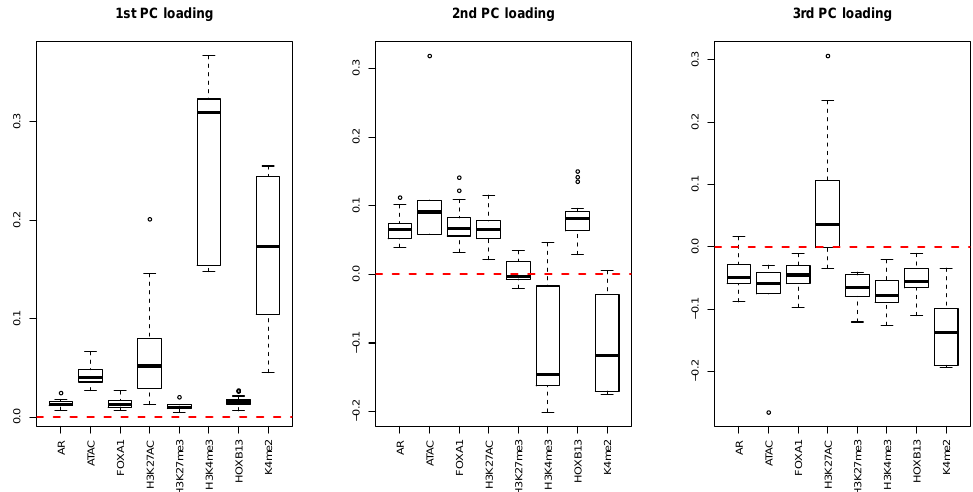
Figure 18. Boxplots of the first to third PC loading attributed to 144 samples classified into eight subclasses, each of which corresponds to a multiomics measurement. The horizontal red broken lines are base lines